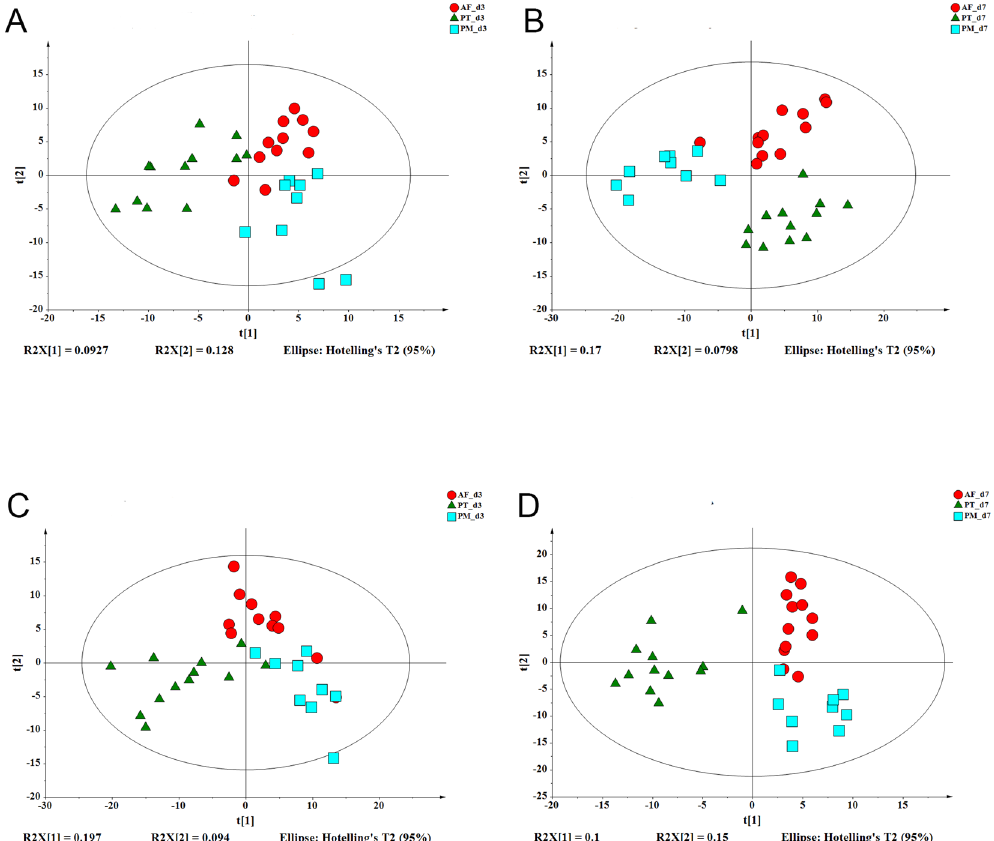
Figure 5. Partial least squares-discriminant analysis (PLS-DA) score plots of metabolite profiles on d3 and d7. ( A and B ) Negative ion mode. ( C and D ) Positive ion mode. The ellipse area represents the 95% confidence interval by Hotelling T2 test. The red circle represents each sample in the antibiotic free group; the green triangle represents each sample in the piperacillin-tazobactam group; the blue square represents each sample in the combination of penicillin and moxalactam group.